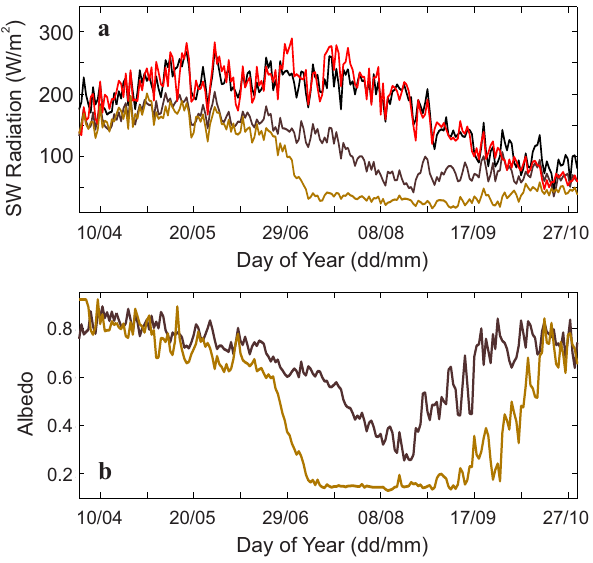
Figure 4. Mean daily (a) short wave radiation fluxes, Wm − 2 , and (b) albedo evolution at the GAWS and FFAWS sites for the pe- riod 1 April to 31 October 2002–2012. Black (GAWS) and red (FFAWS) indicate incoming radiation and purple (GAWS) and brown (FFAWS) indicate the reflected/outgoing radiation and the mean daily albedo.